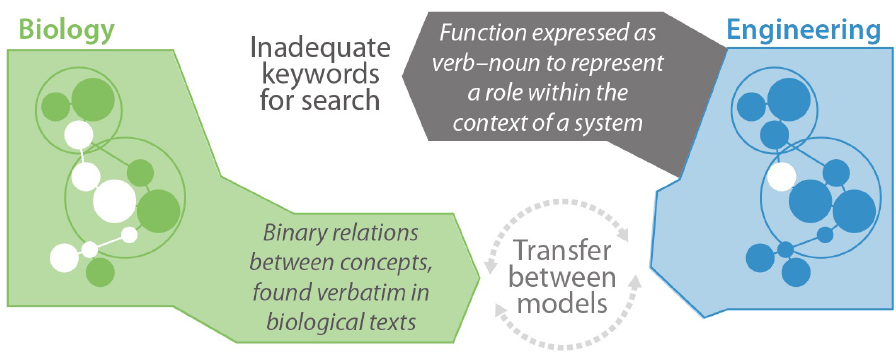
Figure 4. Rather than searching for biological research papers using engineering terminology (top: function bridge), the proposed approach aims to support the modeling of biological systems through elucidating the concepts and relations in a text (bottom: modeling context of a process).